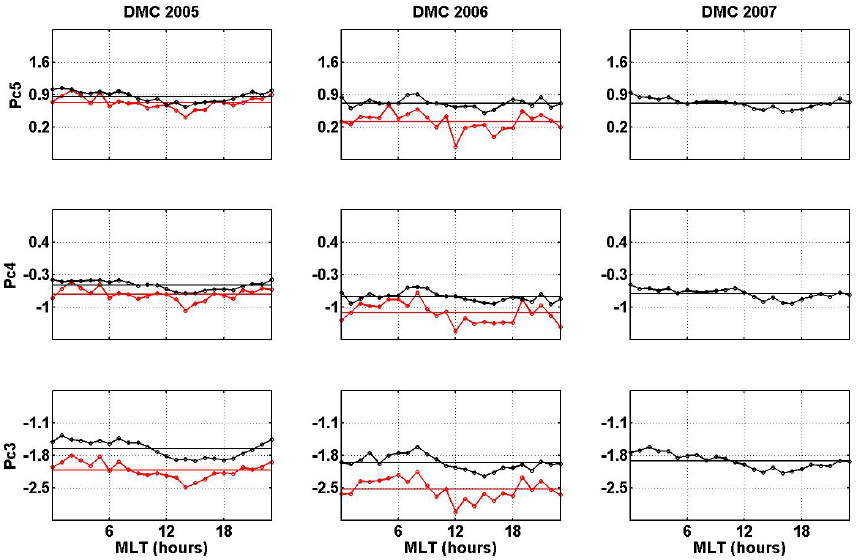
Fig. 3. MLT variation of the hourly power (log scale) of the horizontal component at DMC through the years 2005–2007 in the Pc5 (top panels), Pc4 (middle panels), Pc3 (bottom panels) frequency bands. Black lines correspond to summer while red ones to winter. Horizontal lines indicate the average